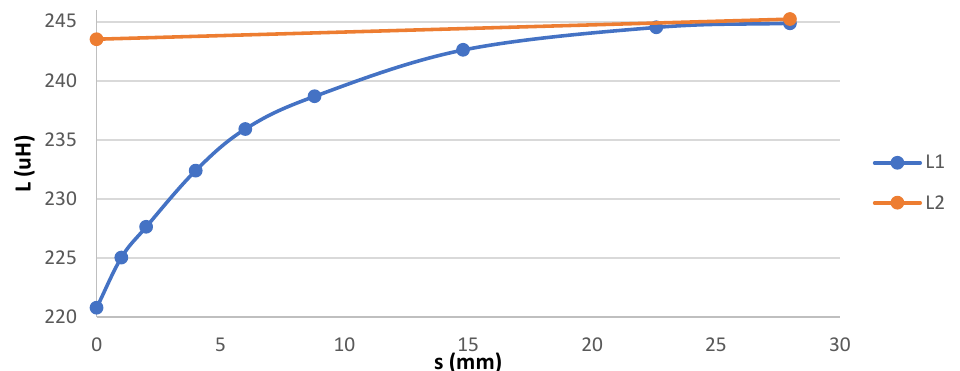
Figure 16. Practical realization of PFC inductor v2 for experimental verifications ( left ) and demon- stration of the evaluation of the inductance value stability ( right ).